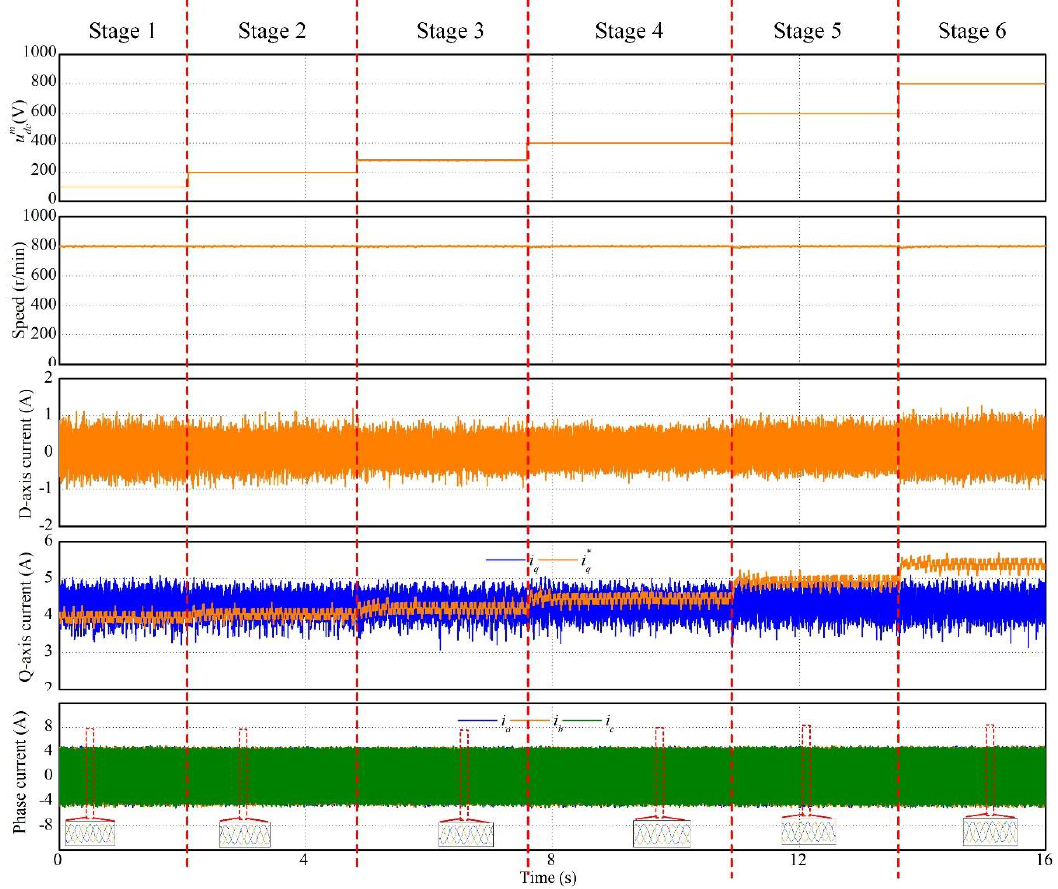
Figure 8. Steady-state performance with DC bus voltage measurement errors.